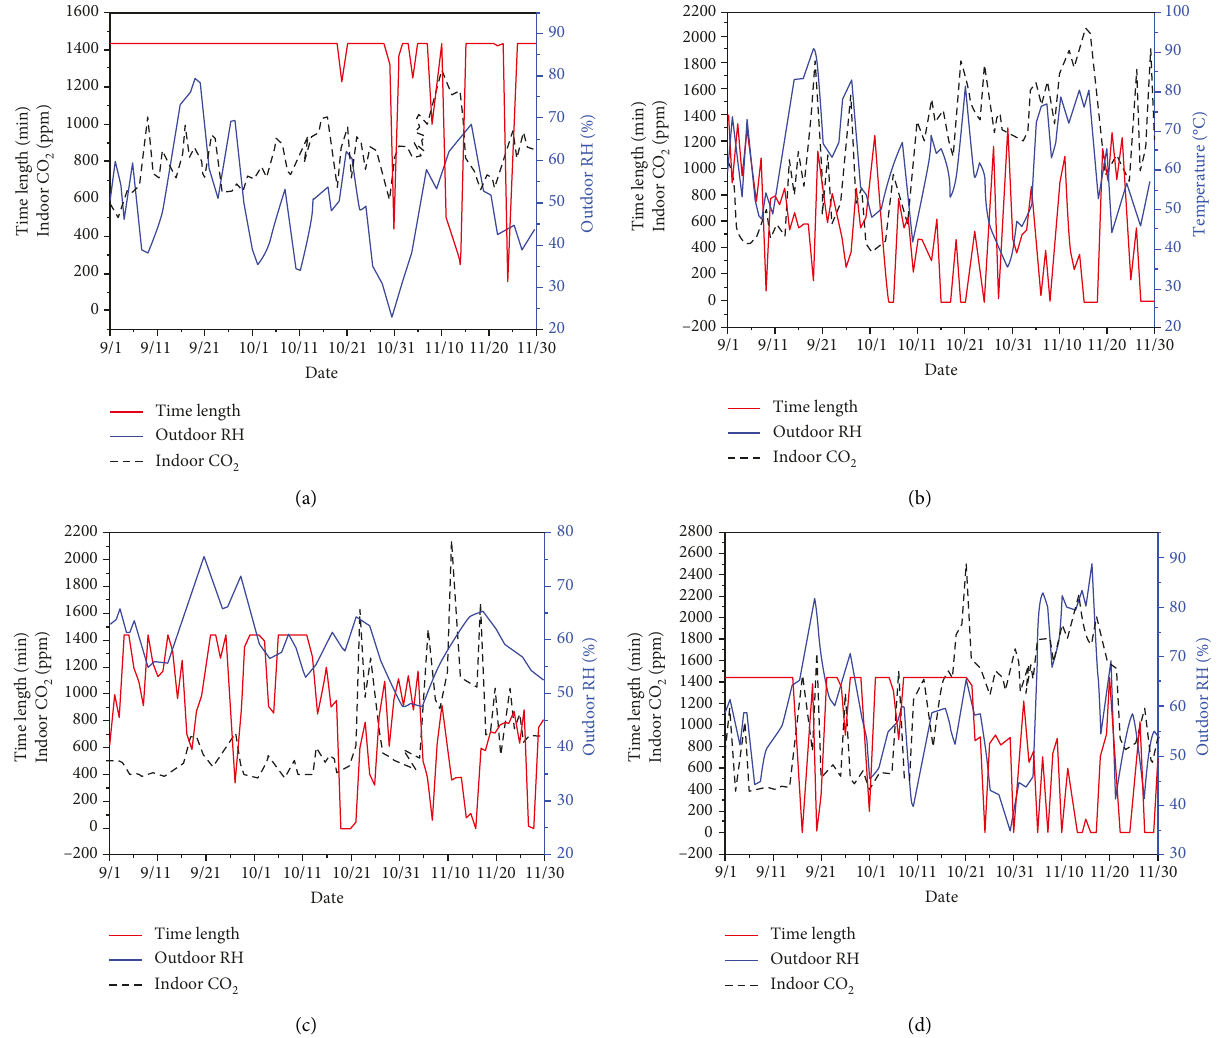
Figure 7: Window opening times and outdoor RH and indoor CO (c) residence #3, and (d) residence